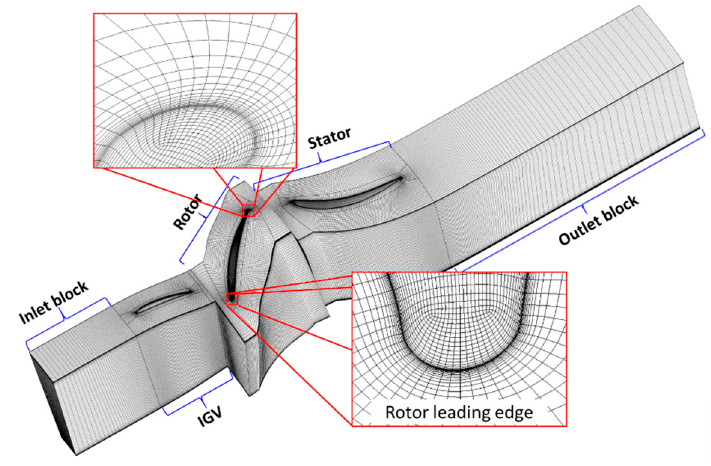
Figure 2. Numerical grids.